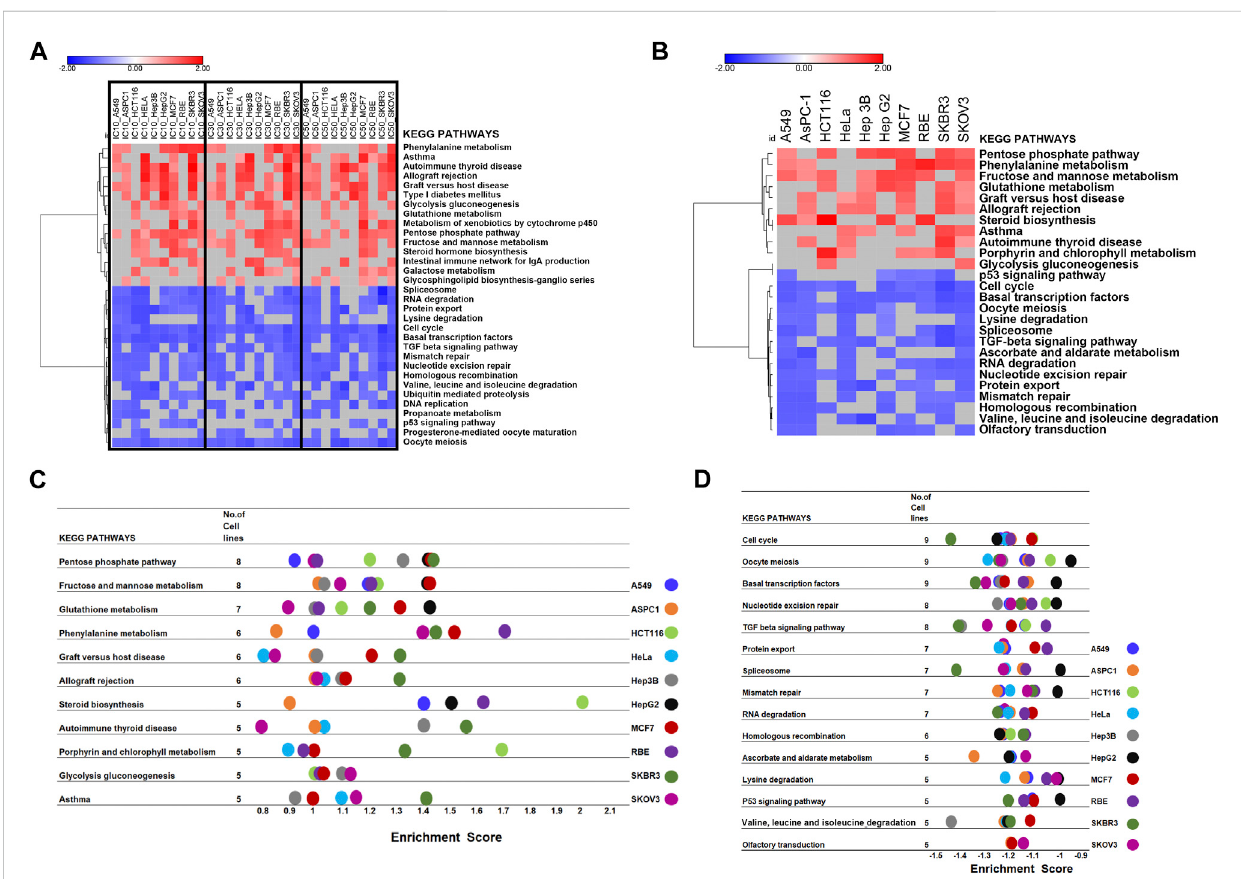
FIGURE 4 GSEA of the transcriptomic data to screen the critical pathway affected by CR among ten cancer cell lines. (A) Hierarchical clustering of enriched pathways from the fi rst GSEA enrichment step was inputting expression pro fi le at the same concentration for 10 cell lines. (B) Hierarchical clustering of enriched pathways fromthesecondGSEAenrichmentstepwasinputting differentconcentrationexpressionpro fi lesfor eachcell lineasthree replicates. (C,D) . Commonly enriched up- and downregulated pathways from the second GSEA enrichment step, treating expression pro fi les under different concentrations in each cell line as three replicates to explore the CR effect in different cell